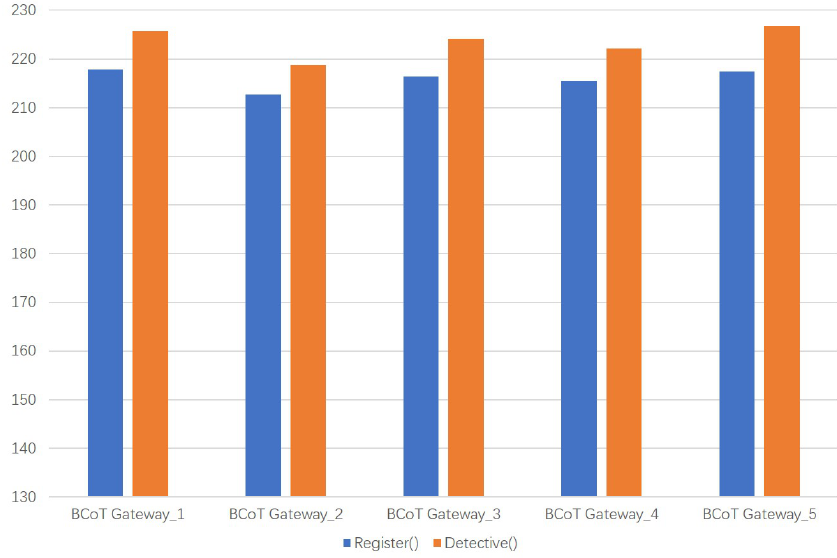
Figure 9. The number of requests responded by each BCoT Gateway per